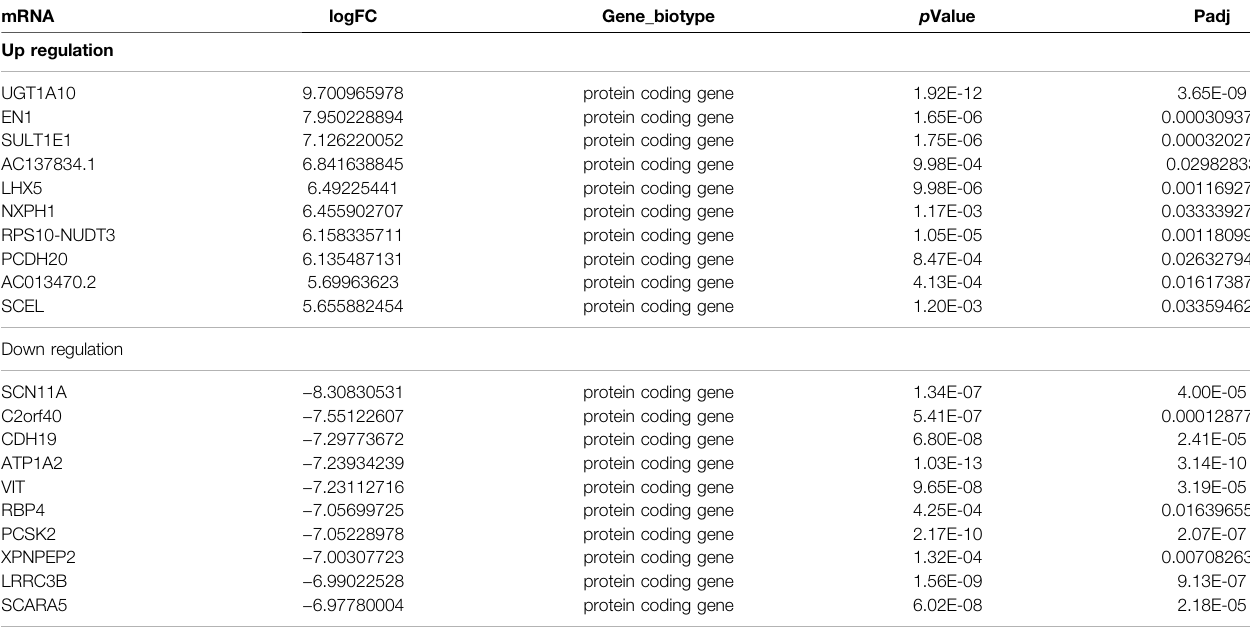
TABLE 2 | Top10 (up- and down-regulated) of differentially expressed mRNAs in bladder cancer and adjacent tissues. mRNA